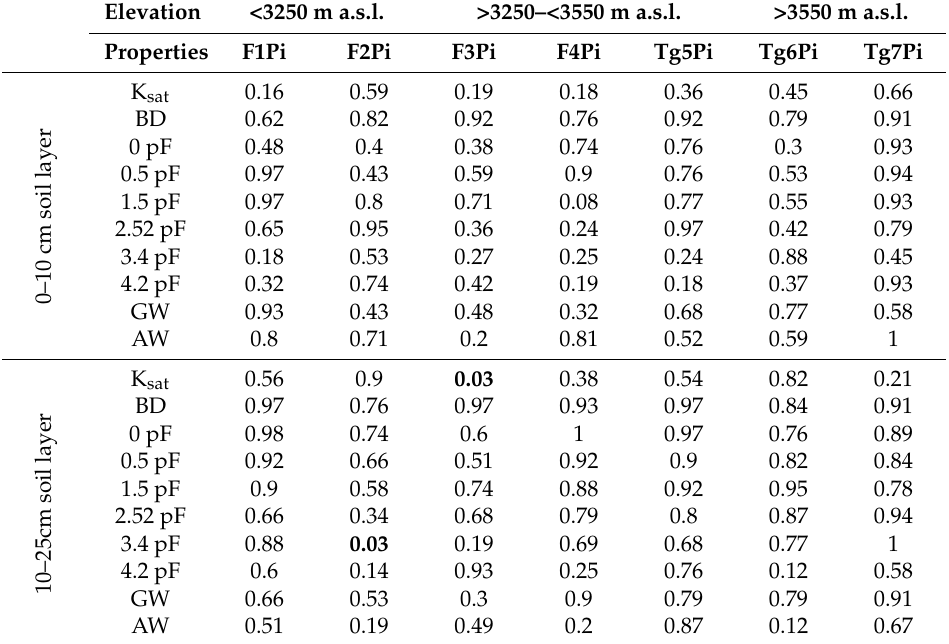
Table A4. p -values of the comparisons of the hydro-physical properties between 75 and 150 cm of sampling distance in each of the pine plantations in the study area. Elevation: <3250 m a.s.l., >3250–<3550 m a.s.l., >3550 m